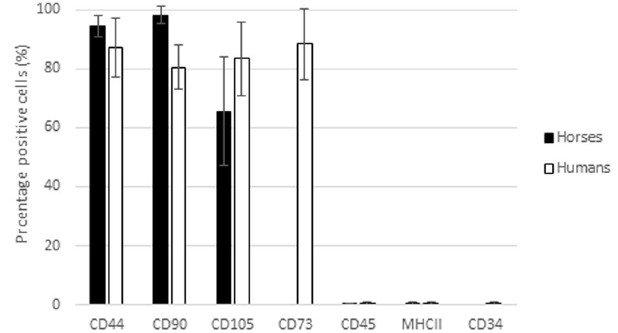
Figure 4. Percentage of positive cells for CD44, CD90, CD105, CD45, MHCII [human (n = 2) and equine (n = 6)], CD73 and CD34 [human (n = 2)] (Mean ± SD).